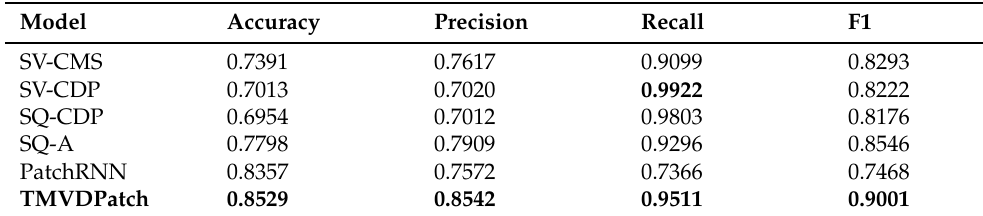
Table 3. The results of model